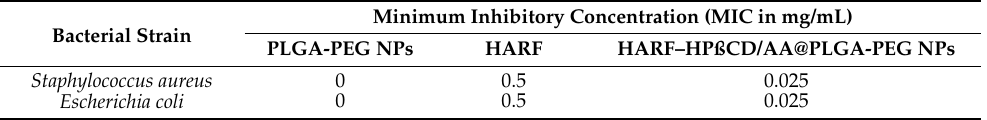
Table 3. Bactericidal activity of HARF and HARF–HPßCD/AA@PLGA-PEG NPs against Staphylococ- cus aureus and Escherichia coli .